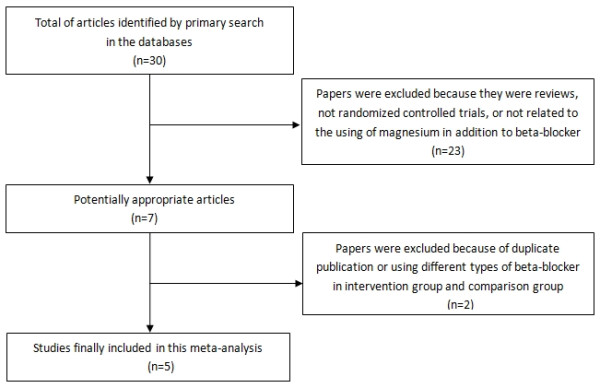
Summary of study selection and exclusion process.